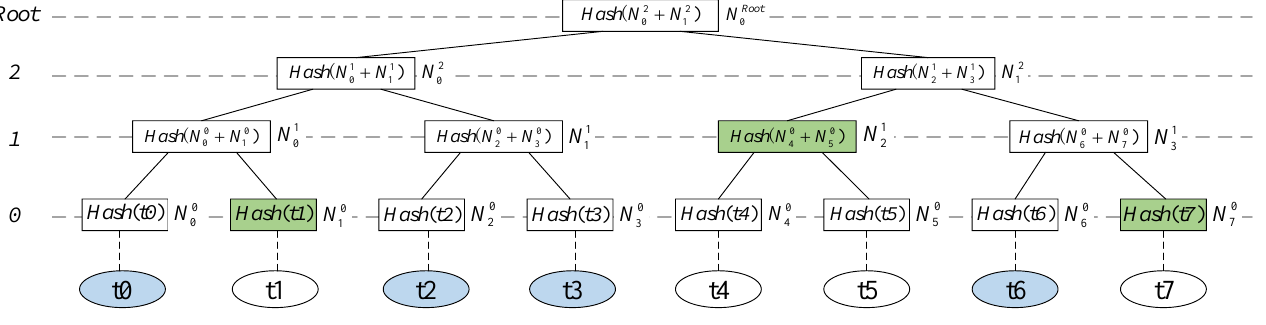
Figure 5. The schematic diagram of sparse Merkle multiproofs for business block.